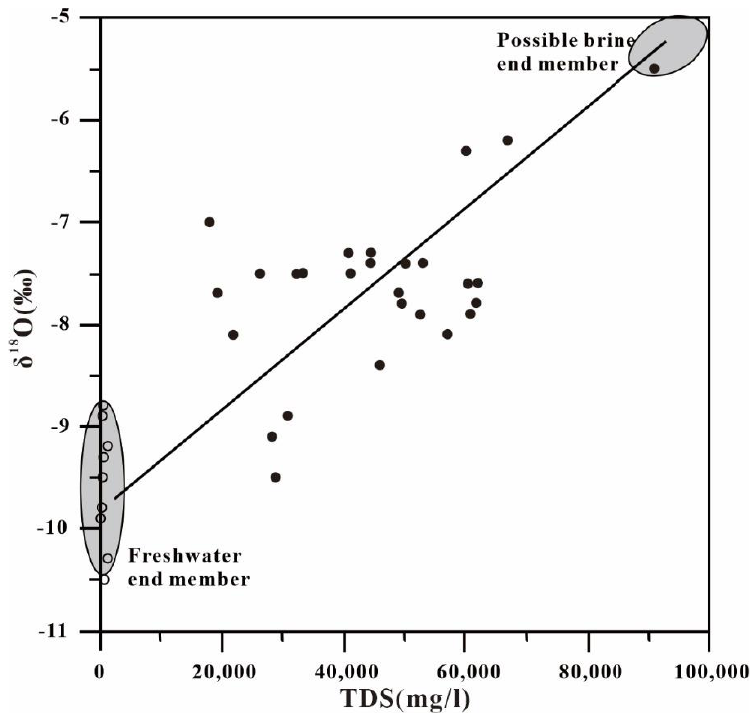
Figure 10. δ 18 O-TDS value relationship of subsurface brine in Xishanzui.